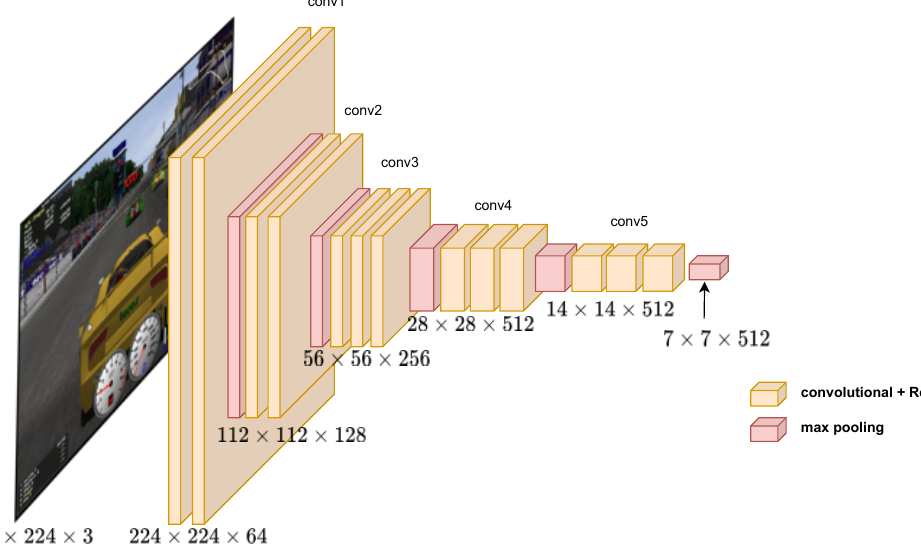
Figure 5. The architecture of the network in charge of obtaining the latent space representation of the images. The size of the input image is 224 × 224 × 3 and it is reduced to 7 × 7 ×